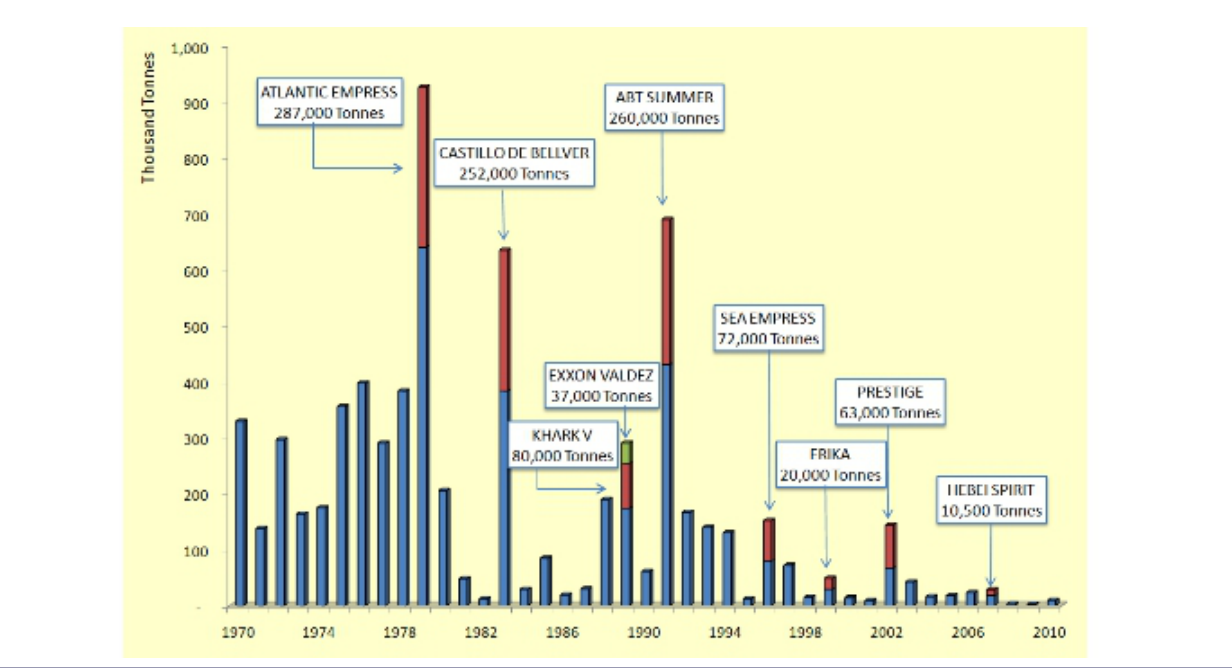
Fig. 2 . Quantity of marine oil spills (metric tonnes) worldwide from